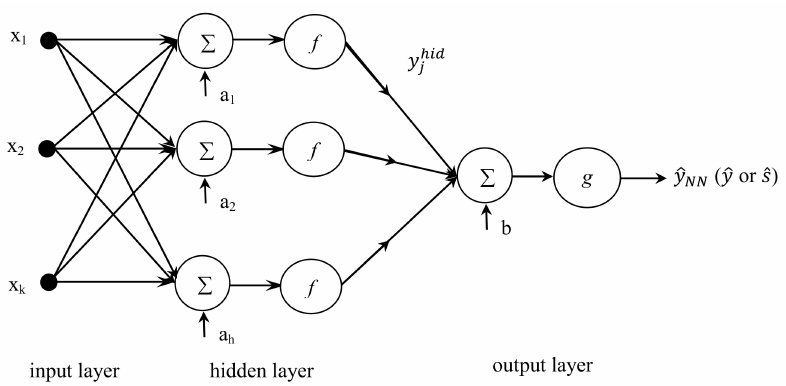
Figure 2. Proposed feed-forward NN-based RD estimation